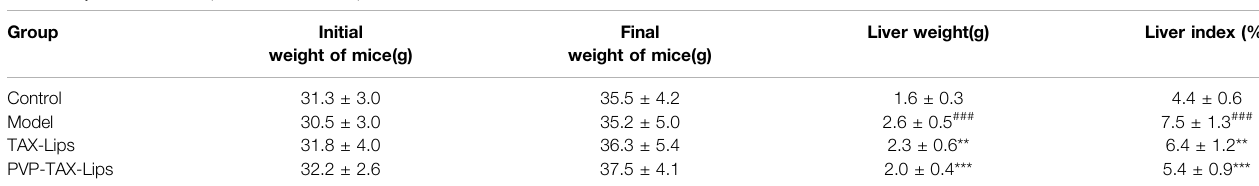
TABLE 2 | Effect of TAX-Lips and PVP-TAX-Lips on the liver index in mice.